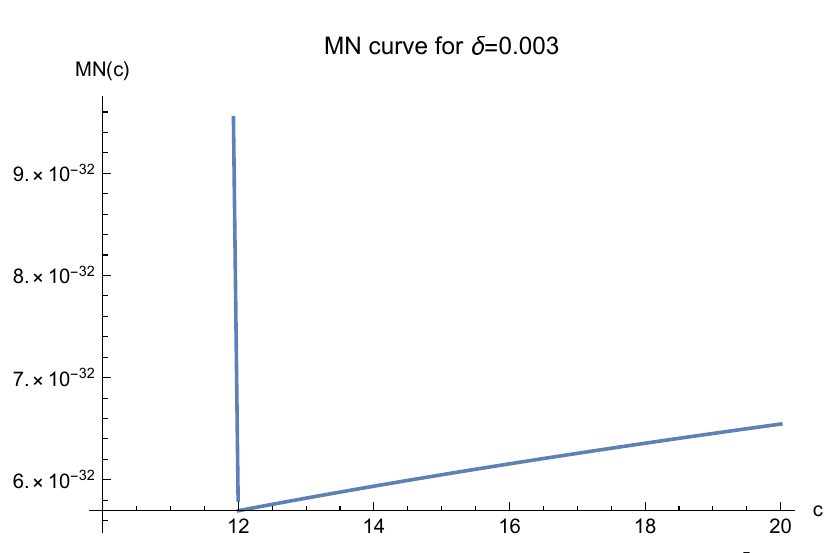
Figure 4. MN curve for δ = 0.005 where d = 1, β = 1, b 0 = 1 and σ = 10 − 5 .